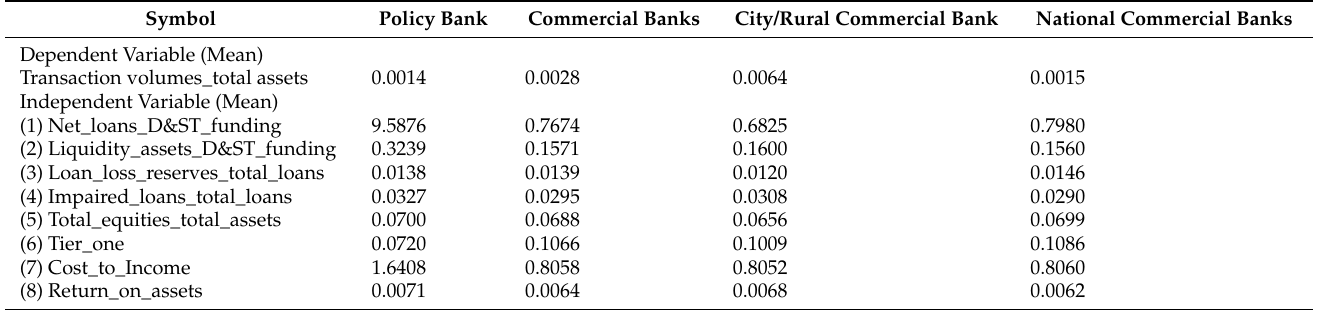
Table 7. Bank-specific determinant variable comparison